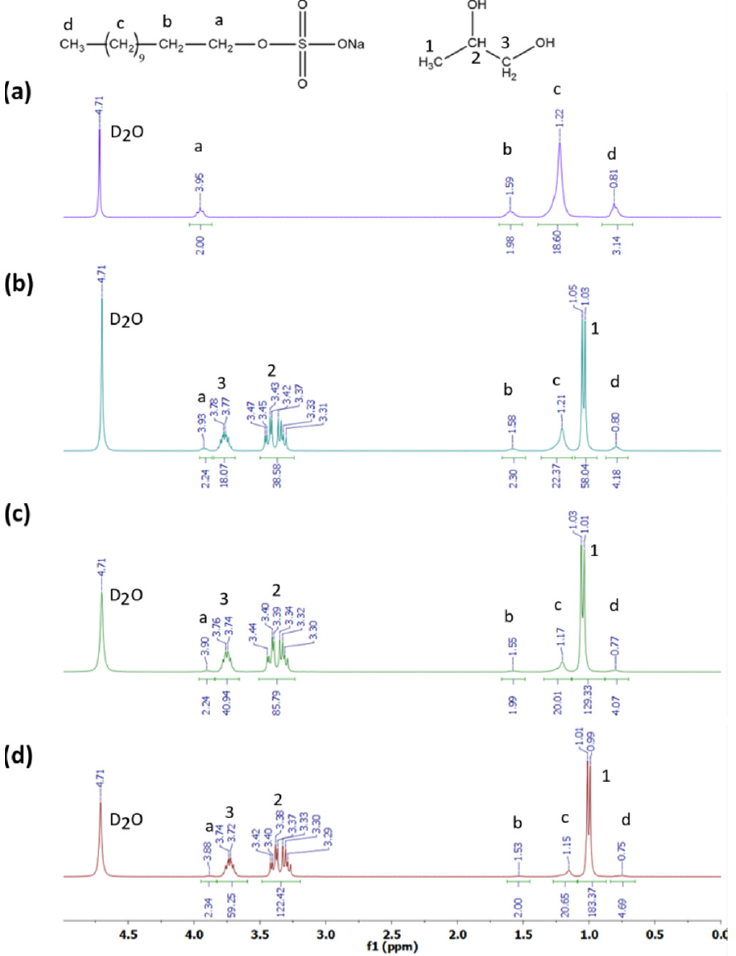
Figure 3. 1 H NMR results of SDS (0.01 mol dm − 3 SDS solution) in the binary mixture of water and ( a ) 0 mass fraction of propane-1,2-diol, ( b ) 0.05 mass fraction of propane-1,2-diol, ( c ) 0.10 mass fraction of propane-1,2-diol and ( d ) 0.15 mass fraction of propane-1,2-diol.